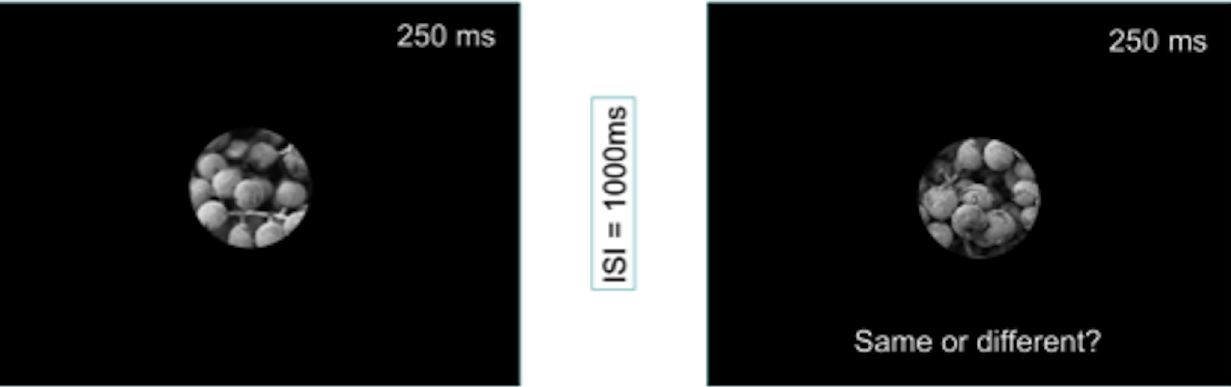
Fig 2. A schematic view of a single trial in our ERP task: Participants viewed sequentially presented texture patches that were either identical, or were different patches drawn from the same larger image. Contrast polarity and real/synthetic appearance were matched for the two images presented in a single trial and otherwise randomized across the